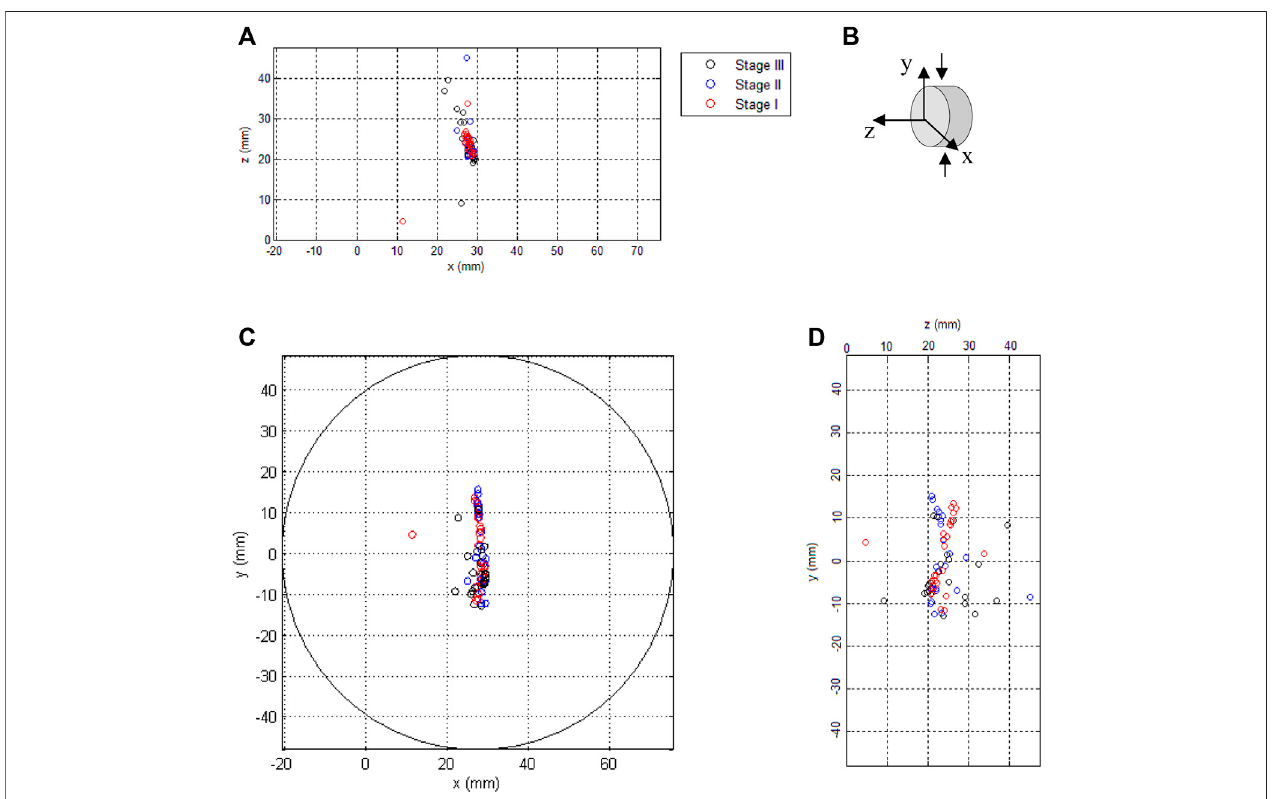
FIGURE4| Cumulative AEsource locations ofthe Braziliantest. (A) top viewofsample, (B) sampleorientationindicatingdirectionofapplied load, (C) front viewof sample, and (D) side view.